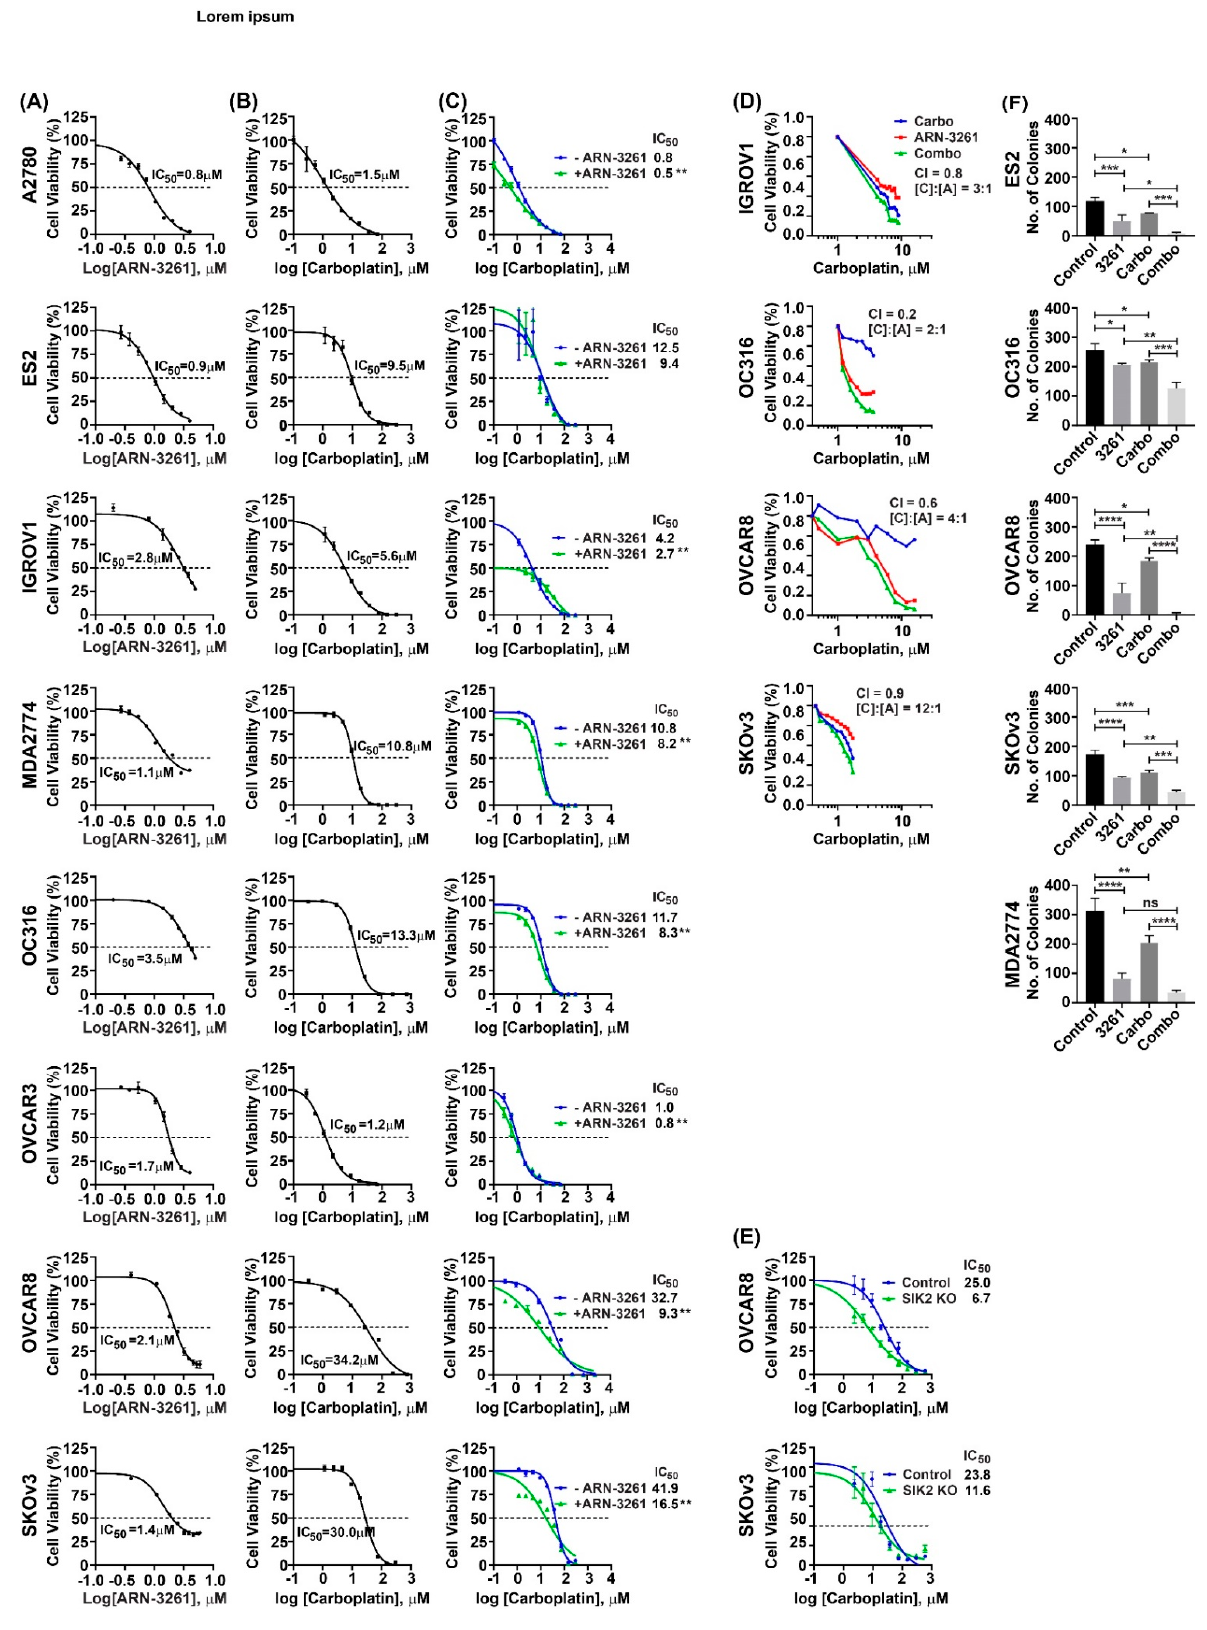
Figure 1. ARN-3261 synergistically enhances carboplatin-induced inhibition of ovarian cancer cell short term and clonogenic growth in cell culture. ( A ) Sensitivity to ARN-3261. A2780, ES2, IGROV1, MDA2774, OC316, OVCAR3, OVCAR8 and